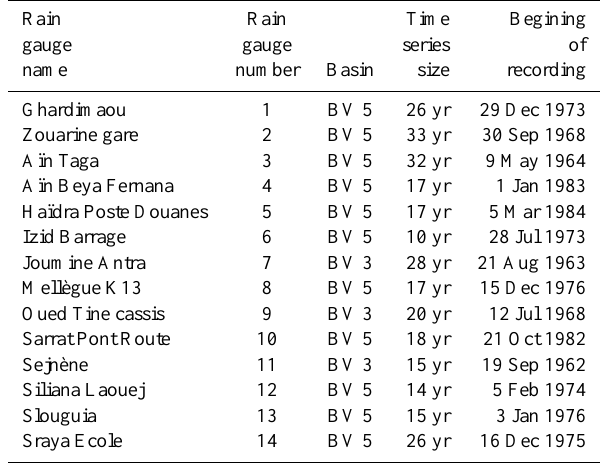
Table 1. Studied rain gauges by DGRE-ST2i